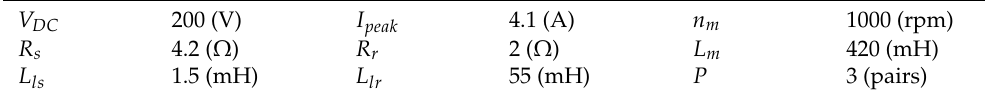
Table 2. Parameters of the 6-phase IM